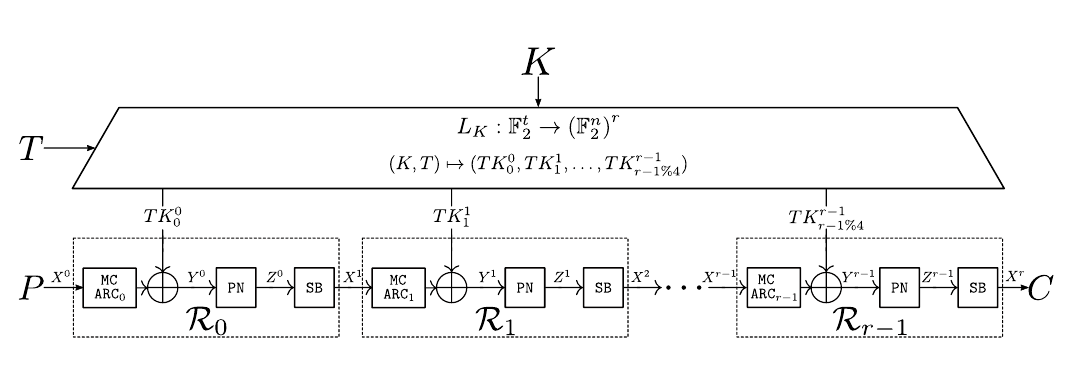
Figure 2: r rounds of CRAFT when r <